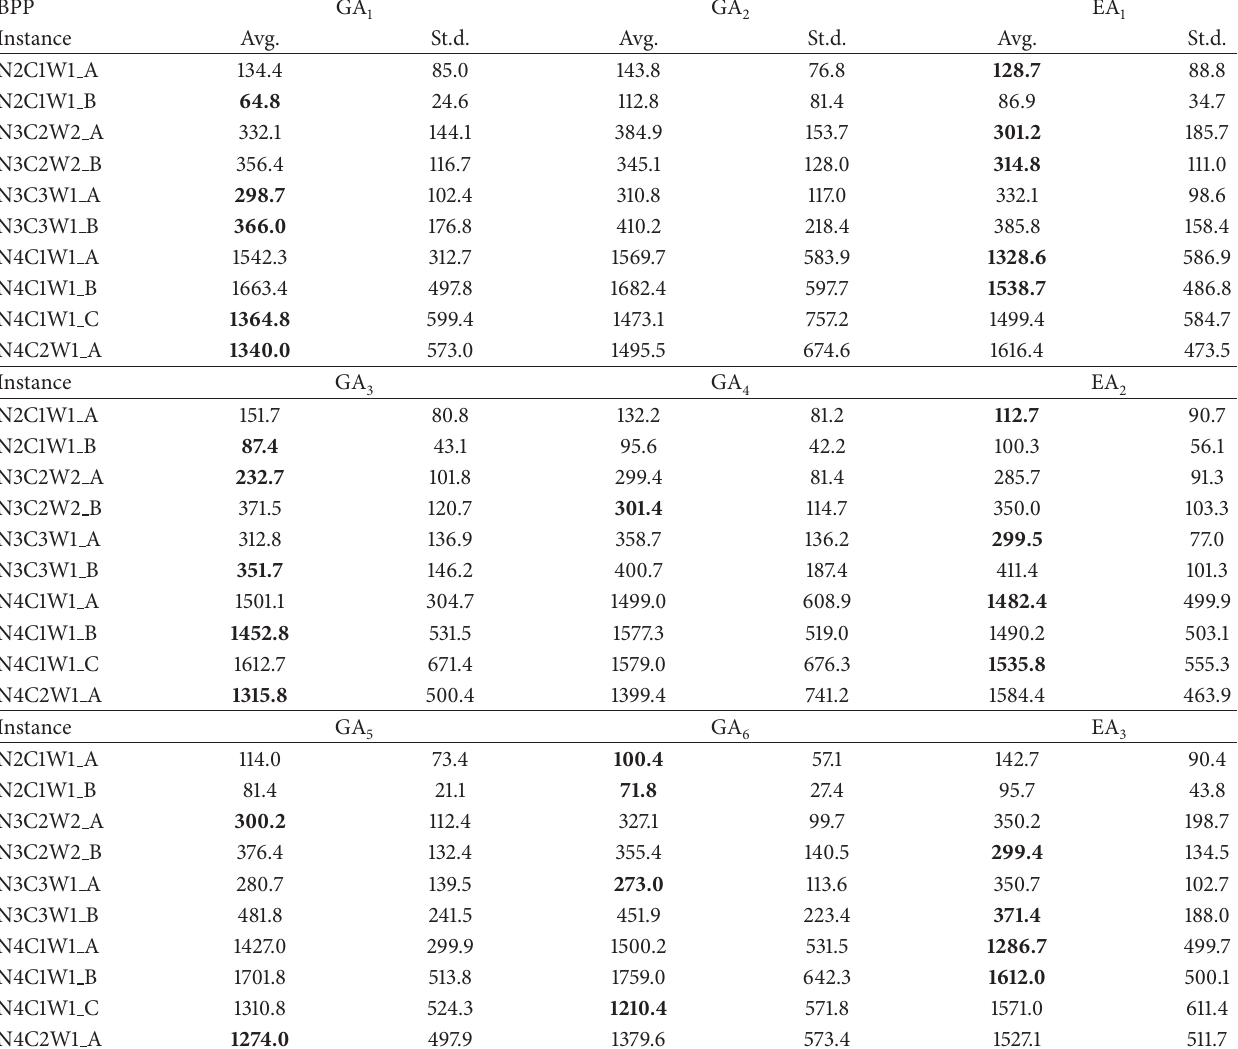
Table 12: Convergence behaviour of the nine techniques applied to the